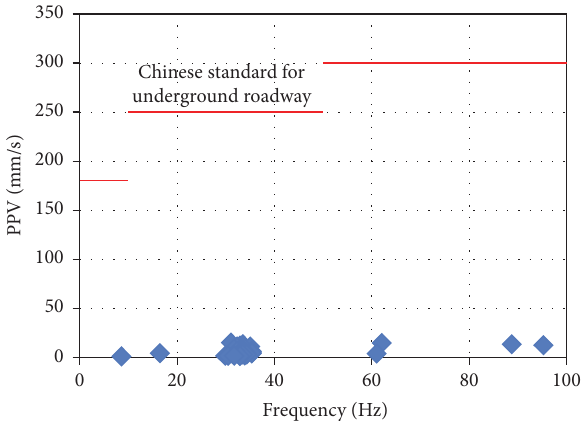
Figure 8: Representation of underground vibration in relation to Chinese standards.